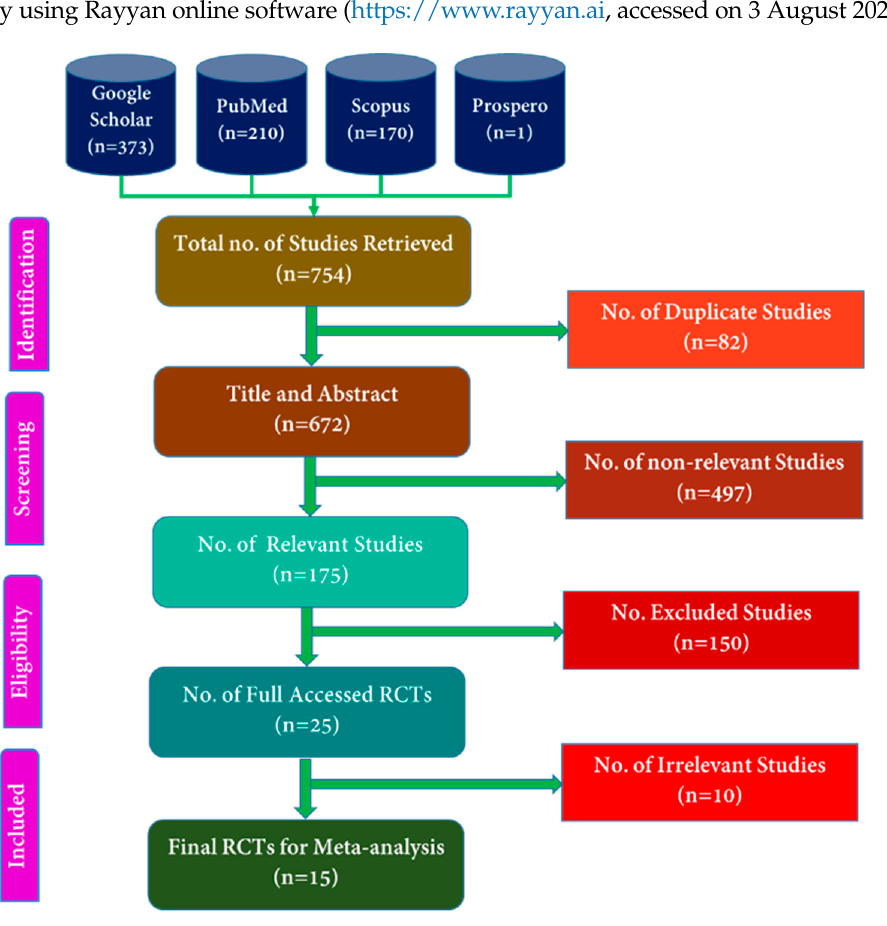
Figure 1. PRISMA flow chart of included publications.